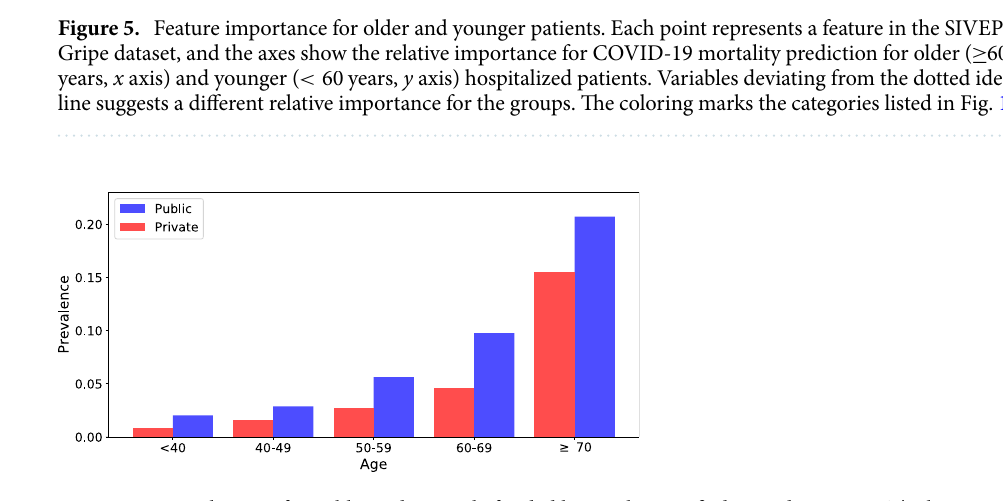
Figure 6. Mortality rate for public and privately funded hospitals, stratified according to age. The bars are normalized by dividing the fatalities by the total number of cases for each type of hospital funding